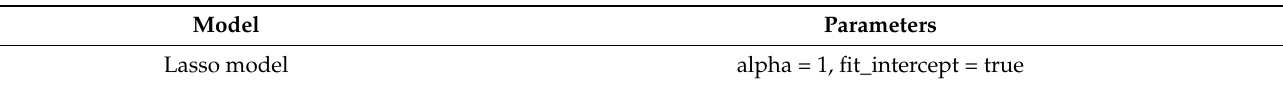
Table 9. Parameters used for lasso model.